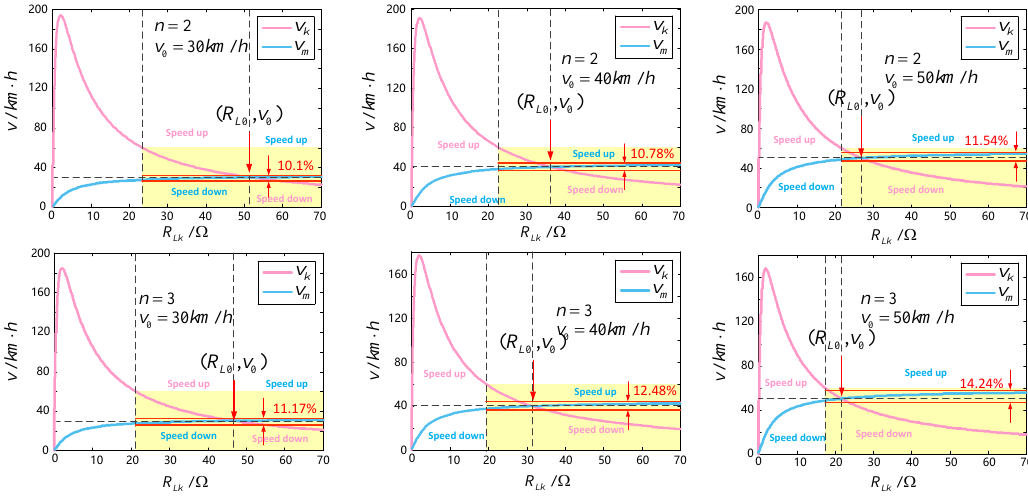
Figure 7. The upper limit of the DWPT driving speeds v k and v m according to the adjustment of R Lk .